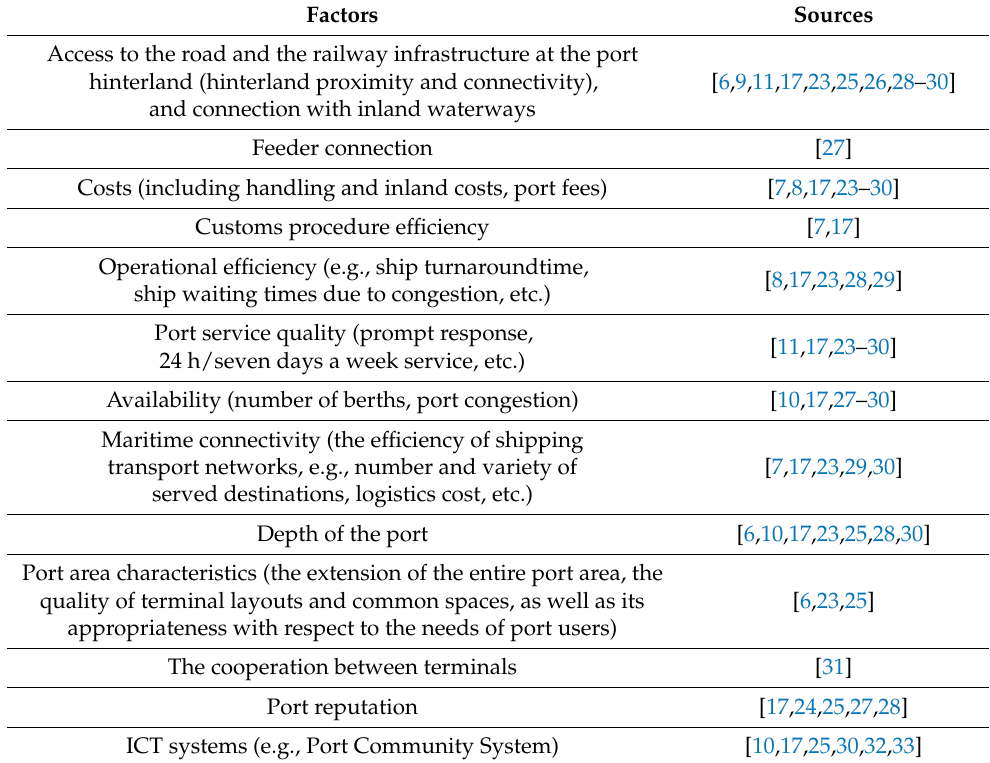
Table 1. Cont. Factors